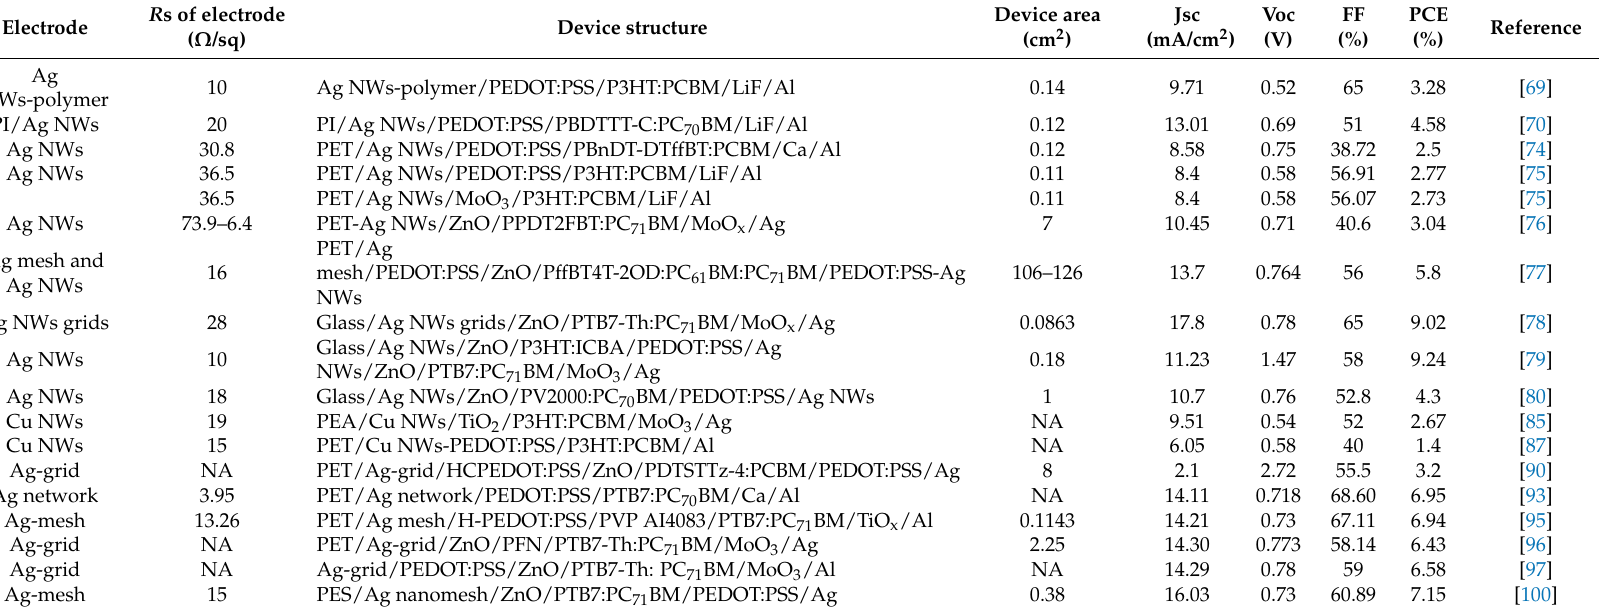
Table 1. Photovoltaic performance of polymer solar cells based on metal nanowires and nanogrids electrodes. R s of electrode Electrode ( Ω